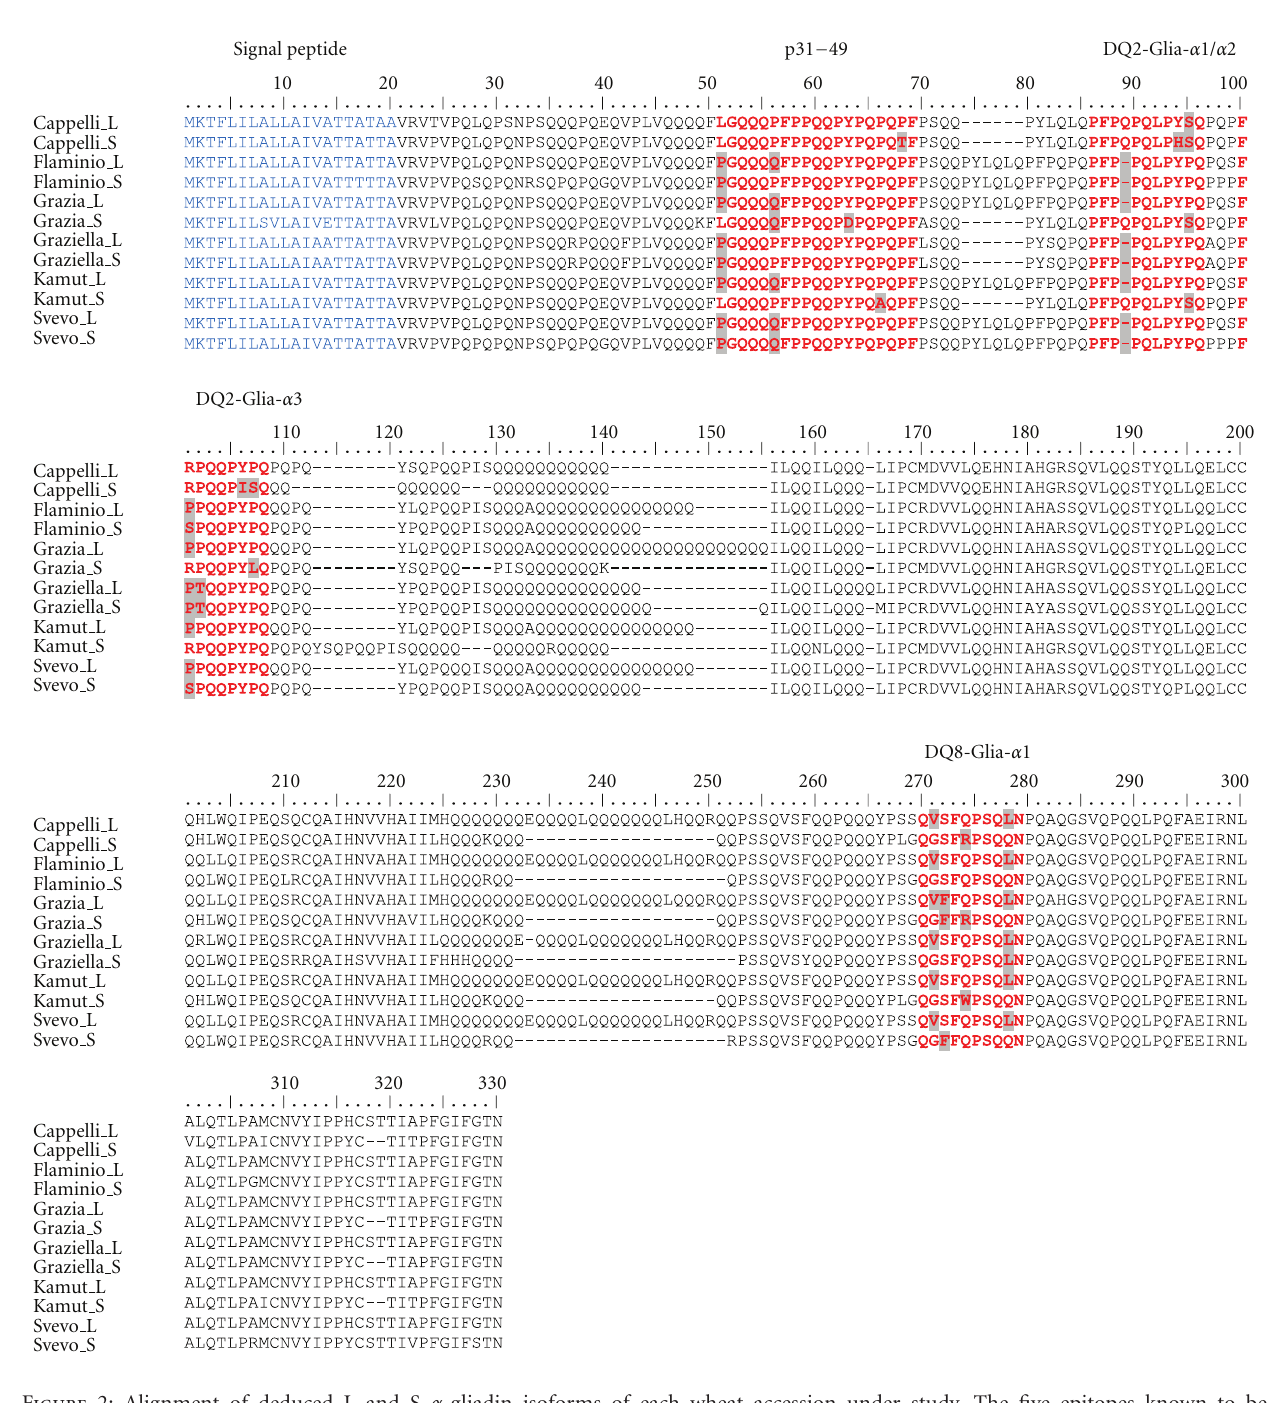
did encounter several variants which, according to Mitea et al. [32], have a diminished or abolished T-cell stimulatory capacity. These include (1) aminoacid deletion at p 4 in DQ2- Glia- α 1 (Flaminio, Grazia, Graziella Ra, Kamut, and Svevo);